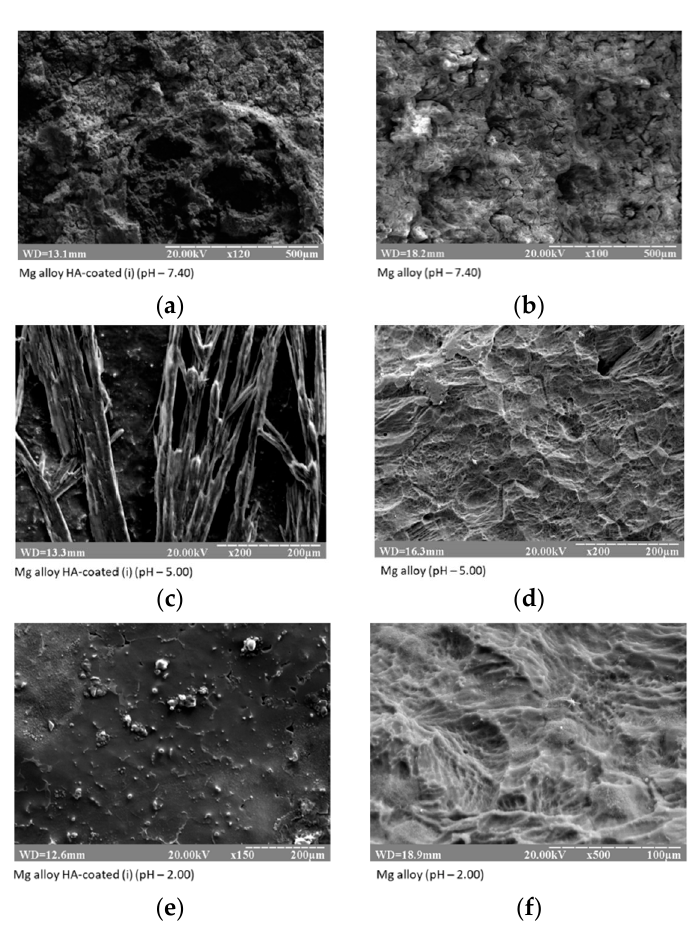
Figure 5. SEM images of the surface of HA–Mg coatings ( a , c , e ) and Mg–alloys without coatings ( b , d , f ) after degradation test for 24 h in SBF (pH = 7.40) and in citrate solution (pH = 5.00 and pH = 2.00). After immersion into citrate solution with pH 5 for 24 h, HA coated Sample (i) was covered by the typical needle-like HA crystals while Mg alloy samples had cellular-like structure. After immersion into citrate buffer with pH = 2 for 24 h a top surface of the coating was dissolved. The surface becomes smooth with some single crystals. In the case of Mg alloy sample citrate solution formed micro points cell cluster structure with higher ridges on its